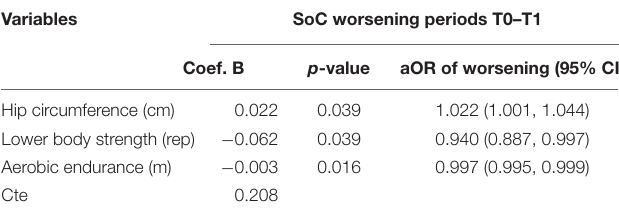
TABLE 6 | Factors associated with the worsening of the SoC between the T0 and T1 periods: Multivariate analysis.